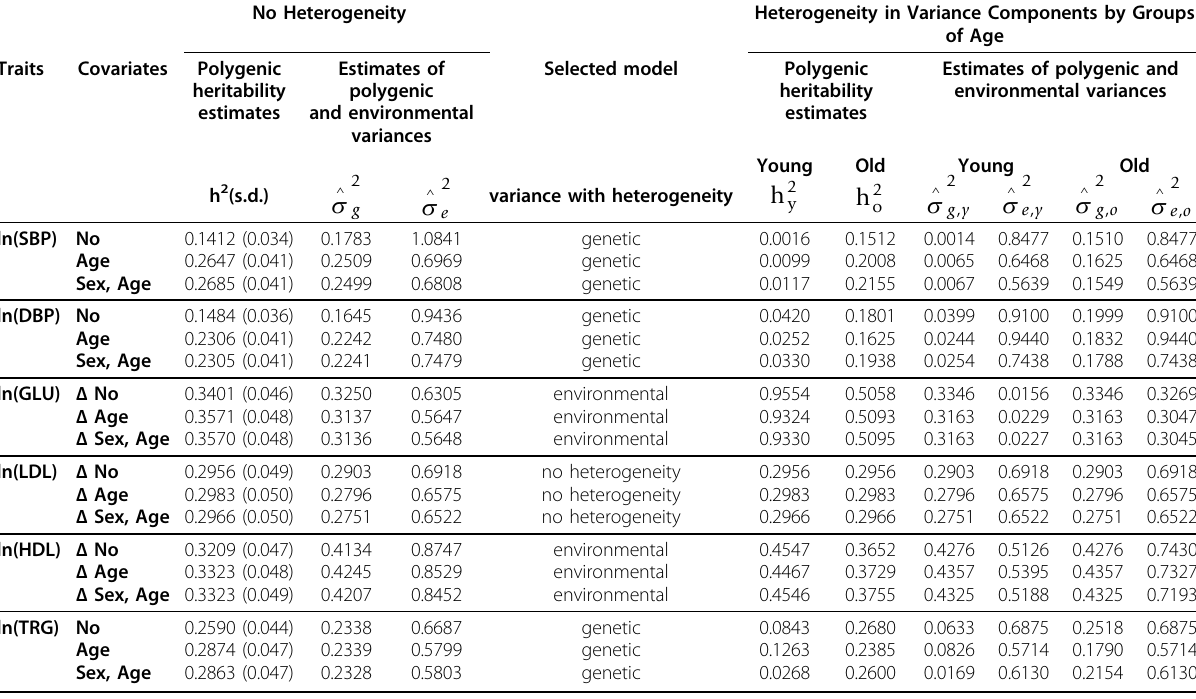
SBP = systolic blood pressure, DBP = diastolic blood pressure, GLU = fasting glucose, LDL = LDL-cholesterol, HDL = HDL-cholesterol. TRG = triglycerides, Δ = the t-dist procedure used in SOLAR,  polygenic variances,  the best